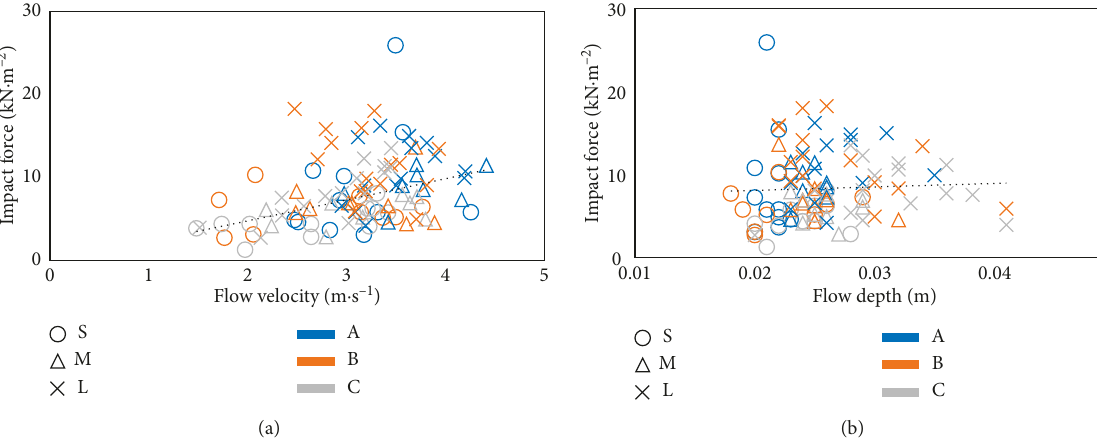
Figure 4: The relationship between impact force and flow behavior. The horizontal axis is flow velocity (a) and flow depth (b). Circle, triangle, and cross symbols mean “S, M, and L” of volume condition. Blue, orange, and gray colors mean “A, B, and C” of viscosity